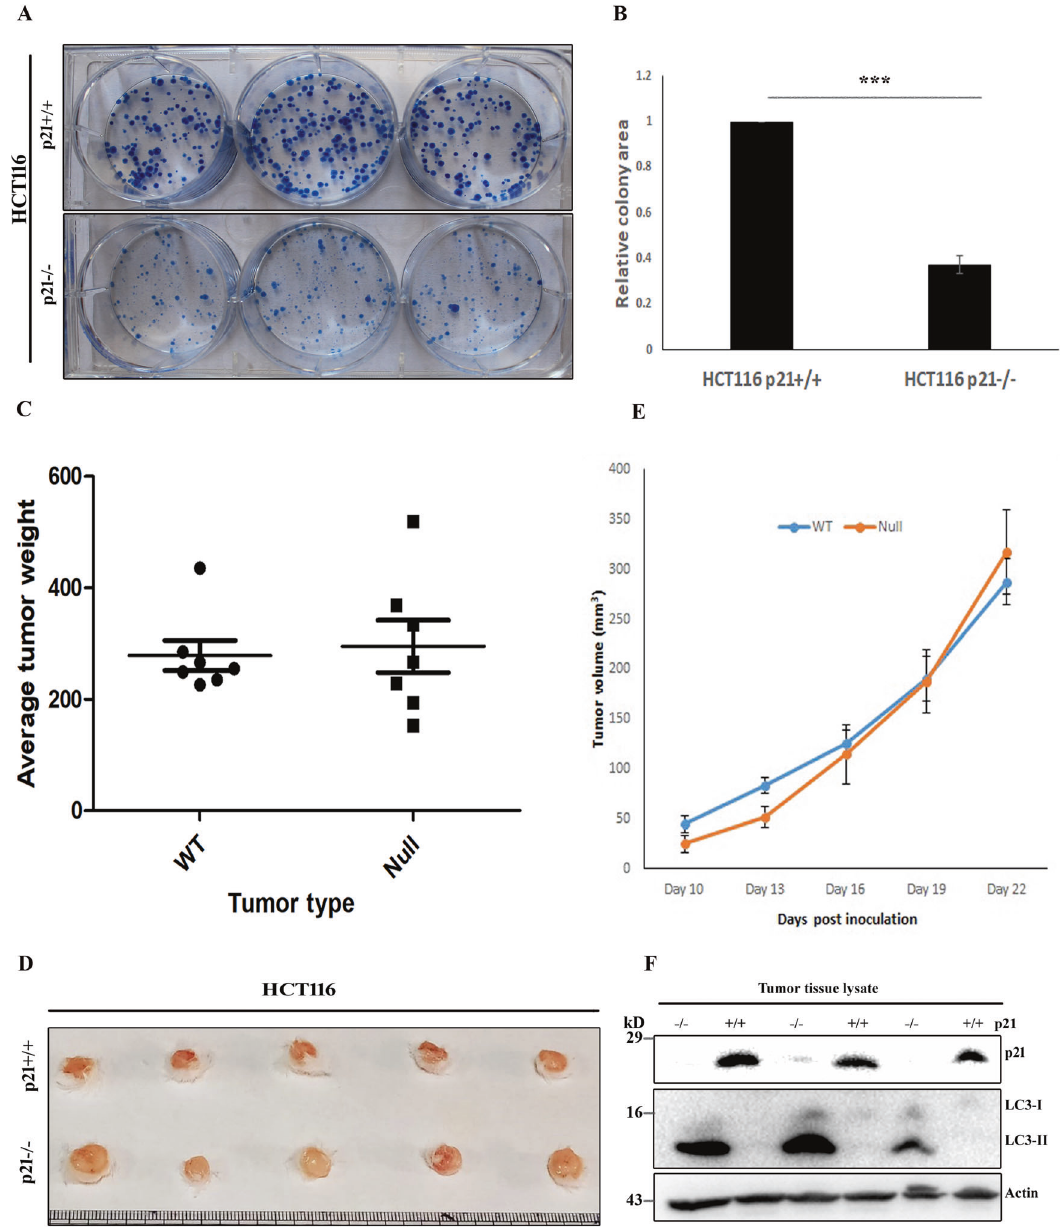
Fig. 6 p21 modulated autophagy affects in vivo tumor growth kinetics. A Approximately 500 numbers of HCT116 p21 + / + and p21 − / − cells per well were grown in a six-well plate for 2 weeks, thereafter fi xed and stained with crystal violet. B Quantitative analyses of colony area by ImageJ. (mean ± SE; *** P < 0.001) C , D NOD/SCID mice were subcutaneously injected individually with equal numbers (5 × 10 6 ) of HCT116 p21wt and null cells at the right and left fl ank, respectively. Tumors were allowed to grow till 3 weeks after which the mice were sacri fi ced to dissect the tumors ( D ) for weighing ( C ); symbols represent individual mouse; data presented as mean ± SE. E Tumor size were recorded at regular intervals during the study and their volumes were calculated as described in Methods section. ( n = 7 per group; mean ± SE are shown). F Tumor tissue lysates were analyzed by immunoblotting to con fi rm p21 expression in respective xenografts and determine relative conversion of